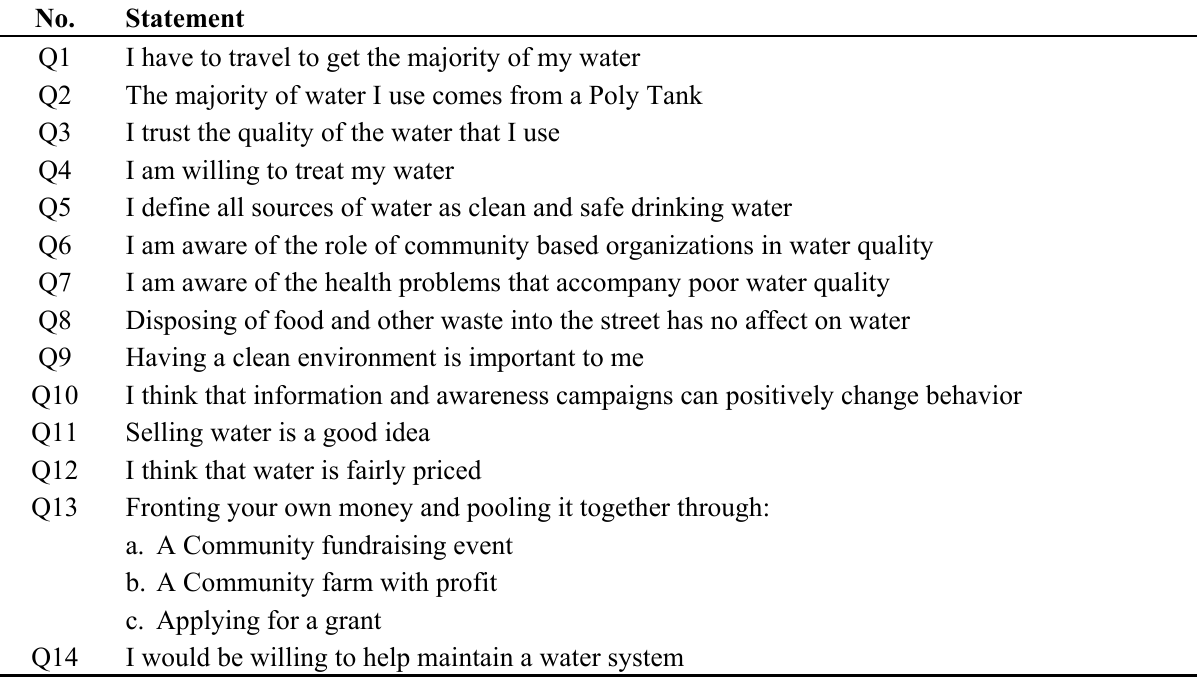
Table 1. Survey Questions Asked to Each Participant within the Yokoè Quarter.